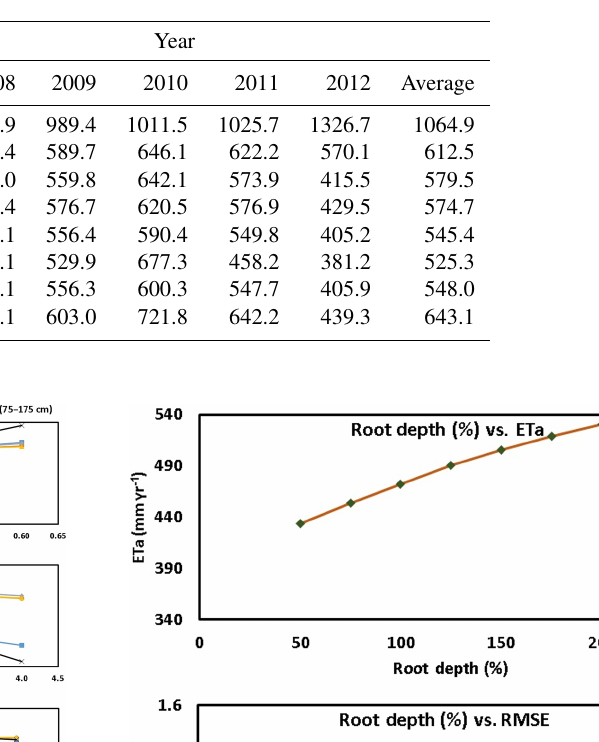
Table 7. Summary of simulated yearly and average actual evapotranspiration (ET a ) (mm) and observed yearly and average actual evapotran- spiration (ET a ) (mm) from the eddy covariance tower from 2007 to 2012.